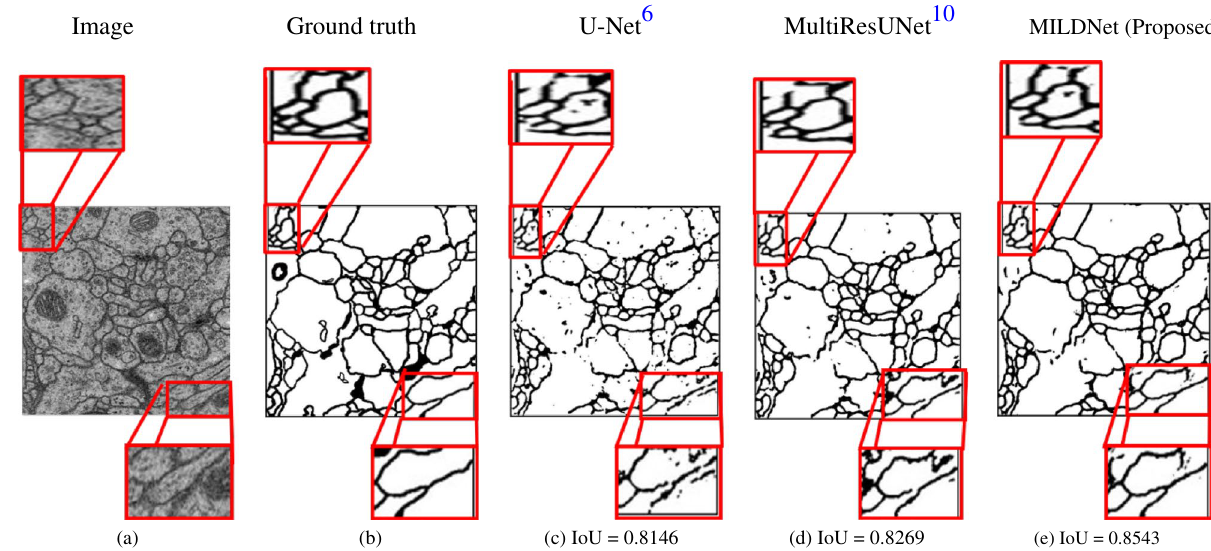
Figure 14. The zoomed areas of the predicted masks in (c–e) show that the MILDNet approach can successfully preserves connectivity in boundaries in an electron microscopy 13,14 image (a) with the majority of the class as being the ROI. The ground truth is given in (b)